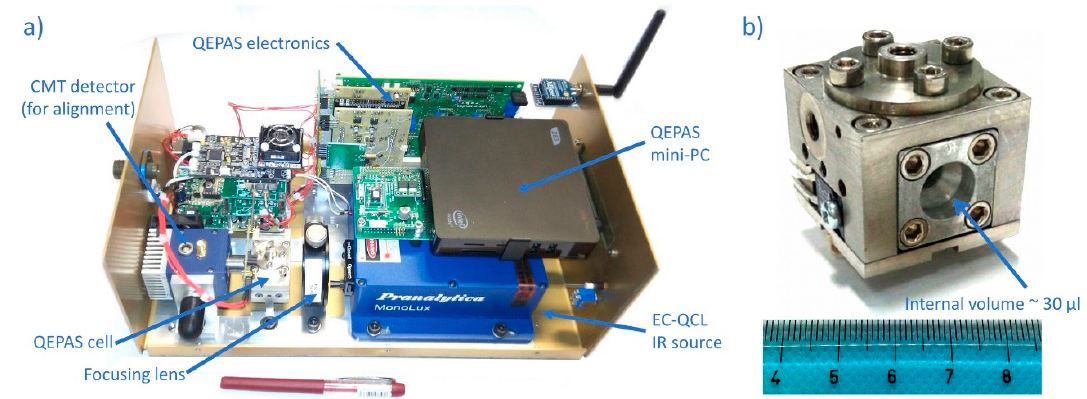
Figure 5. QEPAS module ( a ) and miniaturized QEPAS cell (( b ), scale unit centimeter).